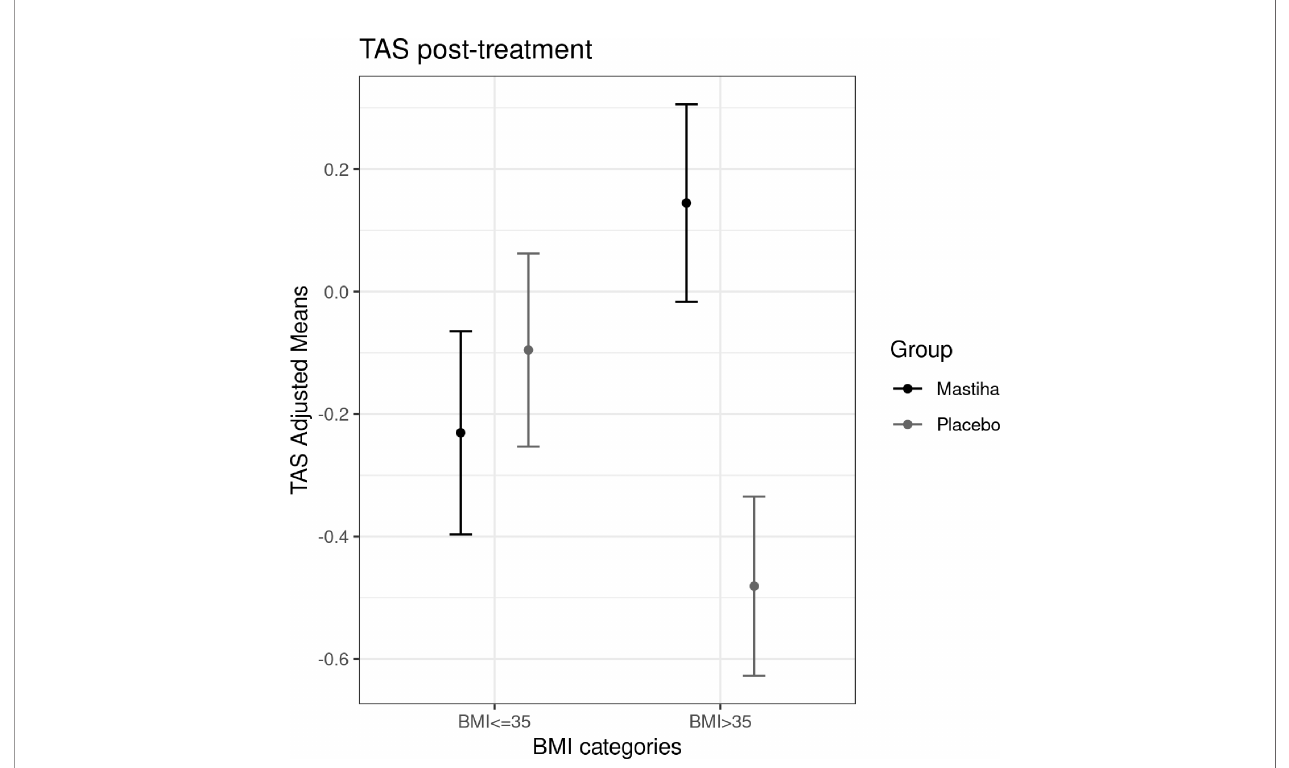
FIGURE 1 | Differences in adjusted means for post-treatment TAS, between the Mastiha and placebo groups, strati fi ed by BMI category. Adjustments were performed for baseline levels of TAS, age, sex and TABLE 3 | Signi fi cant genetic variants-by-Mastiha group interaction results for selected antioxidant and in fl ammatory biomarkers (per SD). Outcome Variant Coordinates* Reference/Other n RAF** Info $ Nearest Allele